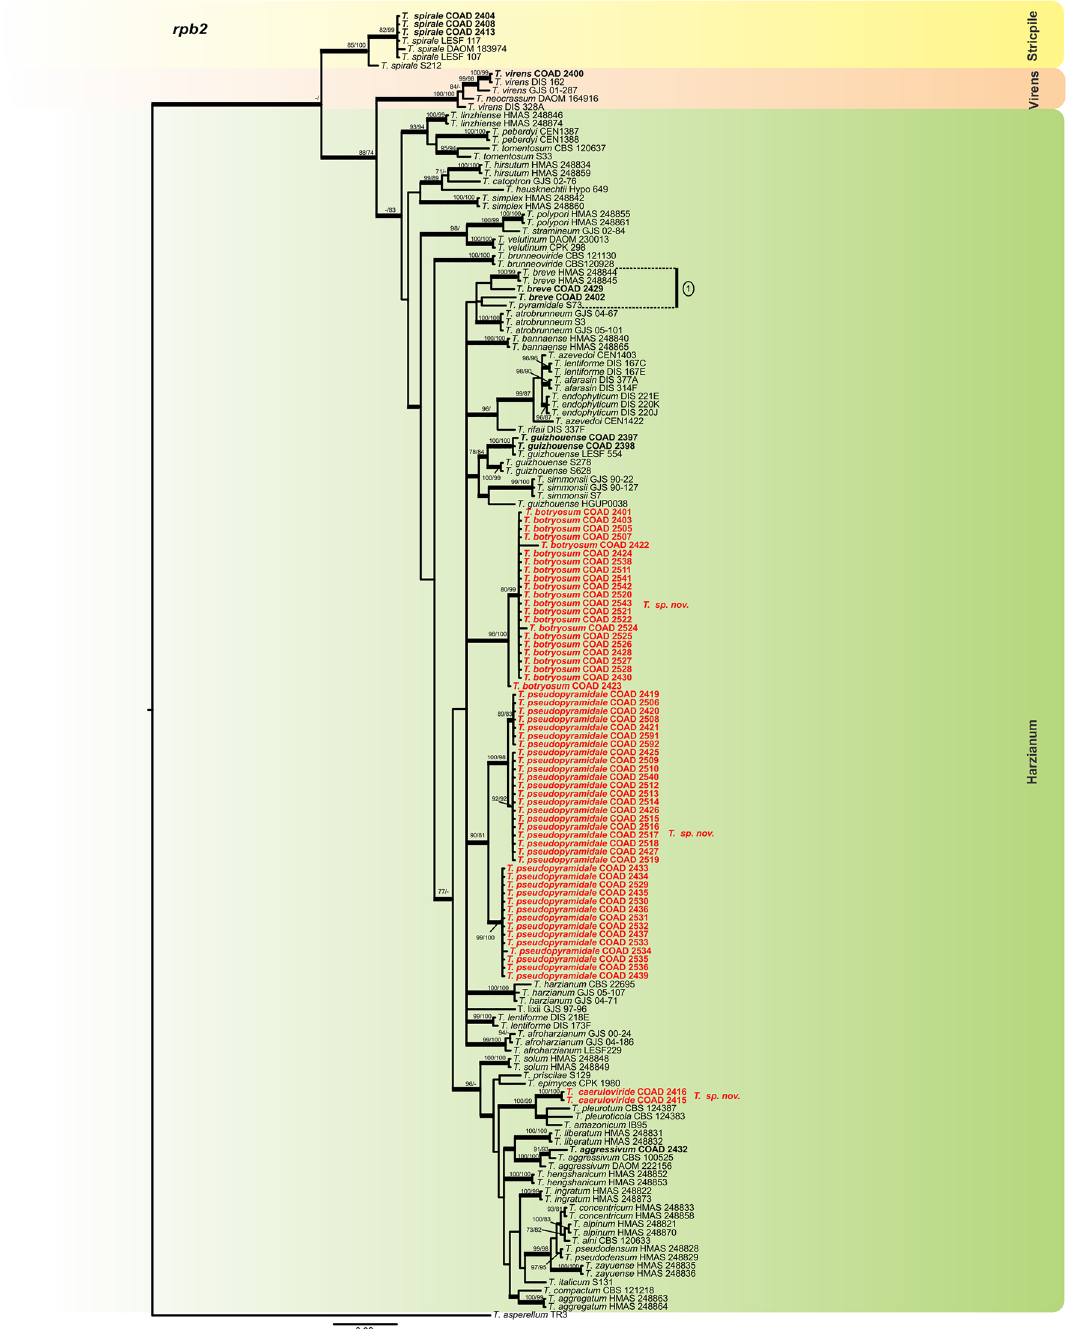
Figure 5. Bayesian phylogenetic tree of clades Harzianum , Strictipile and Virens . The tree was based on rpb2 sequence dataset. Bootstrap values (≥ 70%) of the ML analyses, as well as posterior probability scores (≥ 0.9) from a Bayesian analysis of the same dataset, are indicated at well supported nodes together with thickened branches. The isolates belonging to known species, obtained in this study, are in bold. Isolates of new species, described in this study, are in bold red. The tree was rooted with Trichoderma asperellum (TR3). The phylogenetic tree was edited using Inkscape 1.0 (https ://inksc